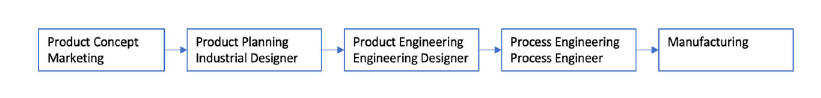
Figure 1. Product development